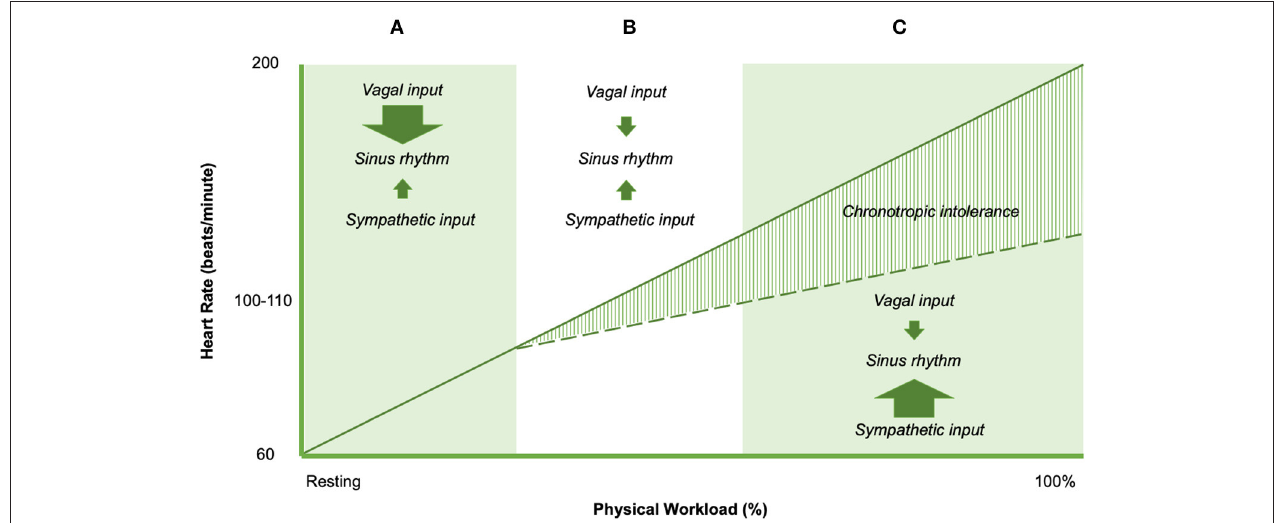
FIGURE 4 | Heart rate responses to exercise in non-ME/CFS (solid line) and ME/CFS (dashed line). Arrow sizes represent the direction and magnitude of the influence of the dominant controllers of heart rate in shaded region.